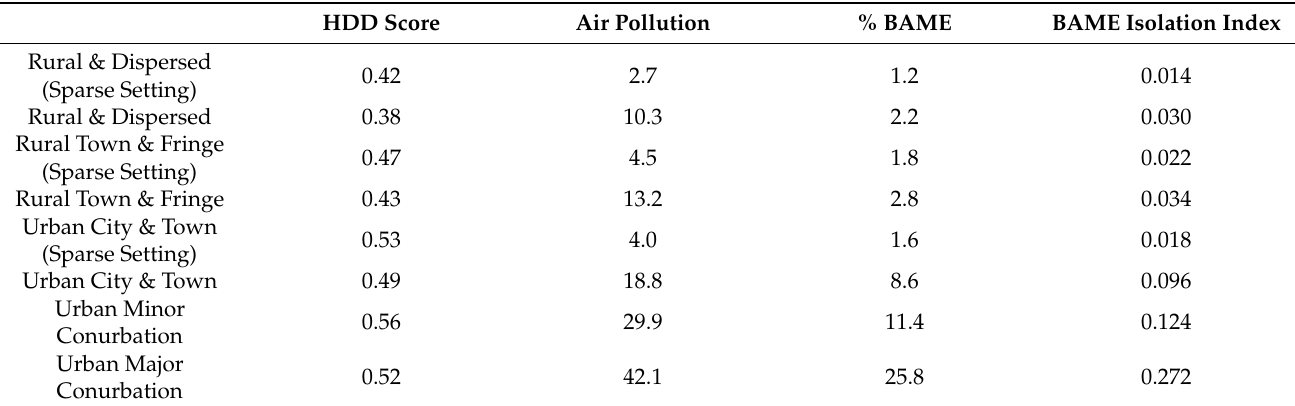
Table 5. Risk Factor Profiles by Urban